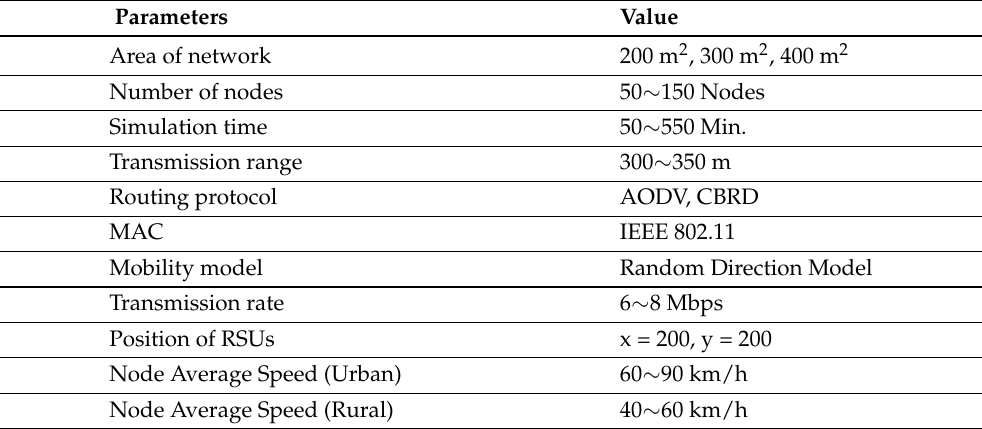
Table 3. Simulation